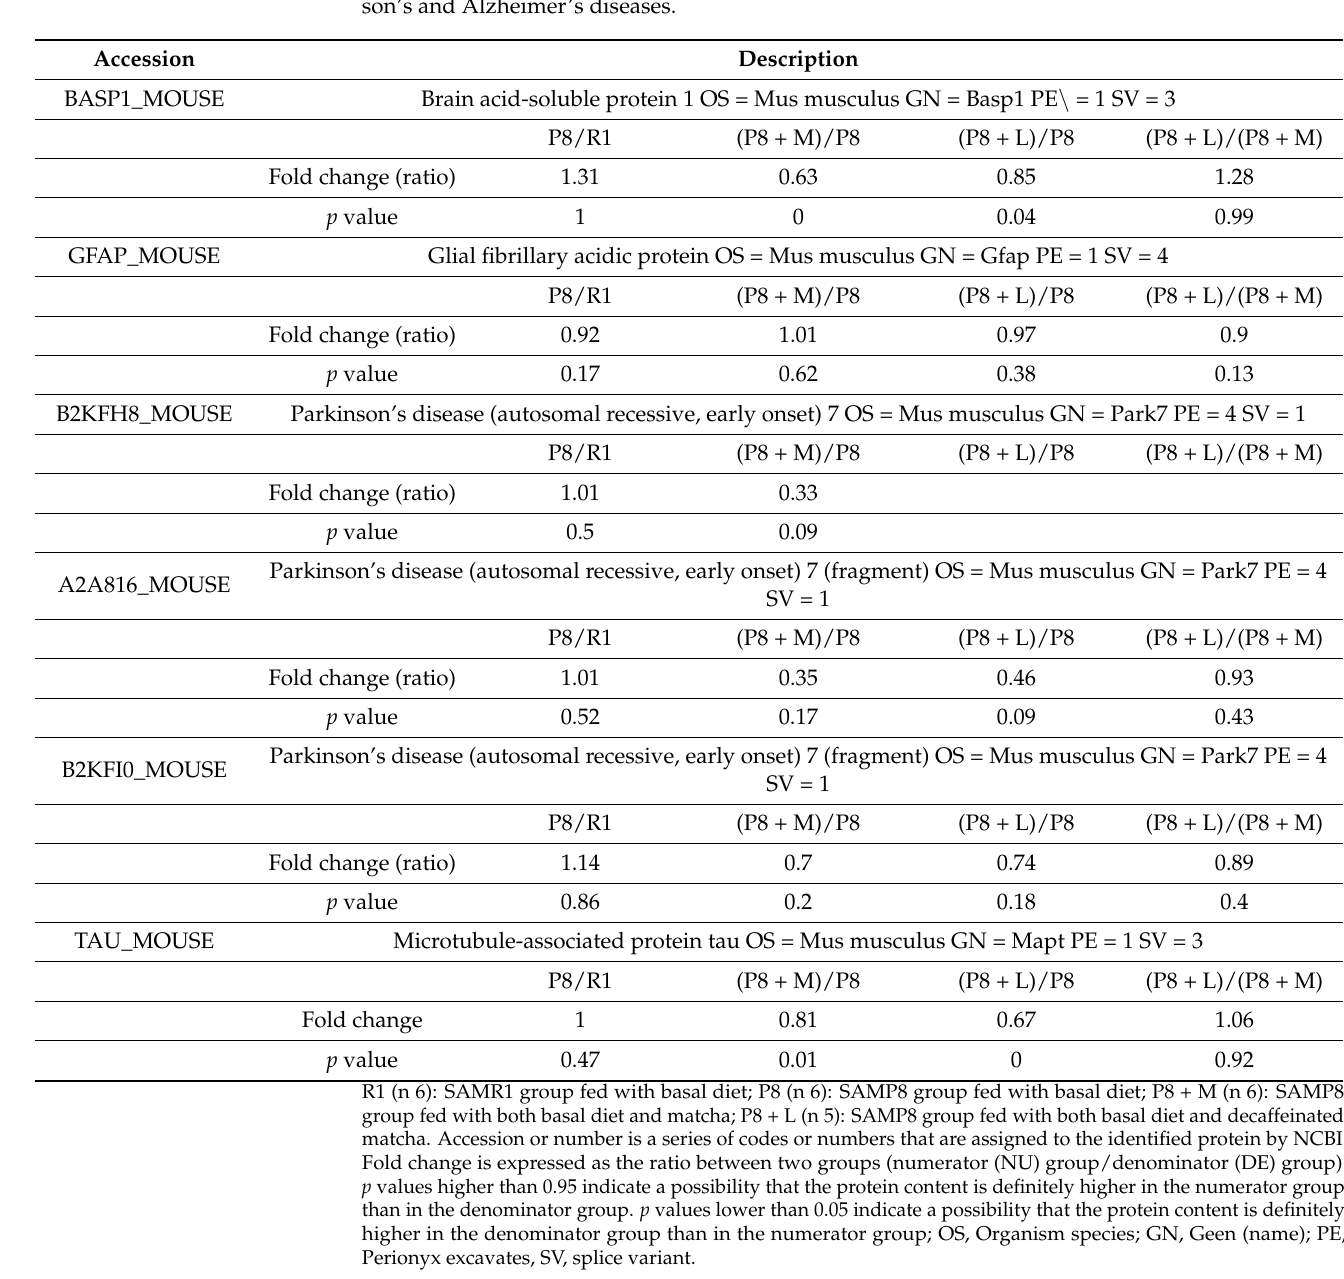
Table 2. Effects of feeding with matcha and decaffeinated matcha on neuron degeneration, Parkin- son’s and Alzheimer’s